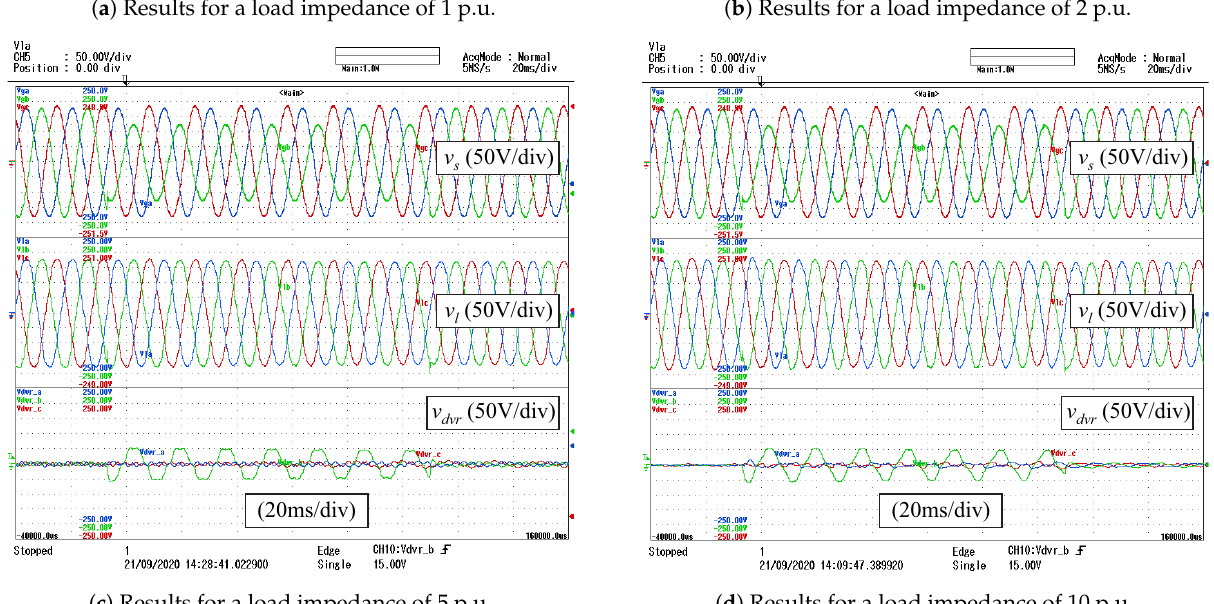
Figure 5. Grid, load and conventional DVR voltages for a single-phase sag (experimental results). Results obtained for S x